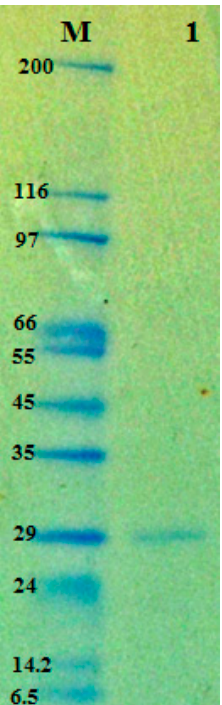
Figure 3. SDS-PAGE analysis of the protease produced by B. licheniformis TKU004. M—molecular markers; 1—TKU004P.